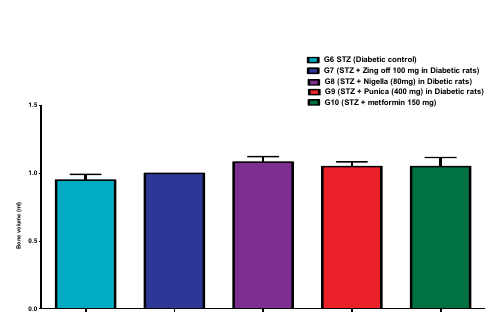
Fig. 4. Comparison of the bone volume (ml) in different studied groups.